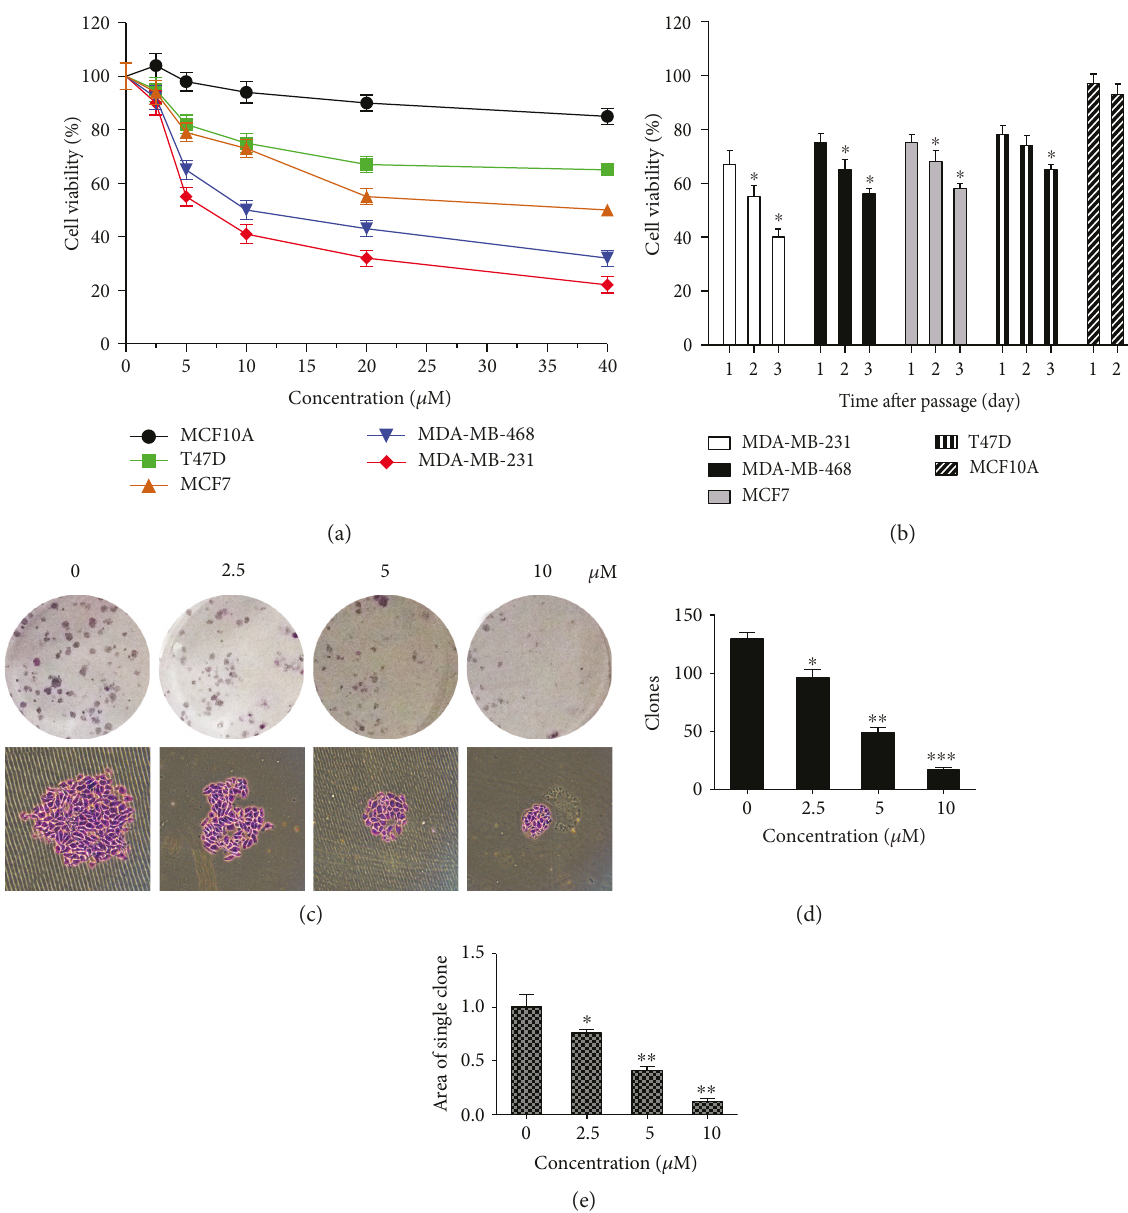
Figure 1: Aloesin inhibits SKOV3 cell growth in a dose- and time-dependent manner. (a) Five ovarian cancer cells were assayed for cell viability determination with the doses of aloesin treatment ranging from 2.5 μ M to 40 μ M. Cells with 0 μ M aloesin treatment were used as control. All groups of cells were cultured for 48 h. (b) At a fi xed dose (5 μ M), aloesin inhibited fi ve ovarian cancer cell viabilities in a time- dependent manner (24 h, 48 h, and 72h). (c) Colony formation assays were performed using SKOV3 cells treated with indicated doses of aloesin. The clones were stained with crystal violet and shown. (d) In the colony formation assay, clones were formed and counted manually for each group of cells. (e) The size of each clone was also calculated and averaged. ∗ p < 0 05 ; ∗∗ p < 0 01 ; ∗∗∗ p < 0 001